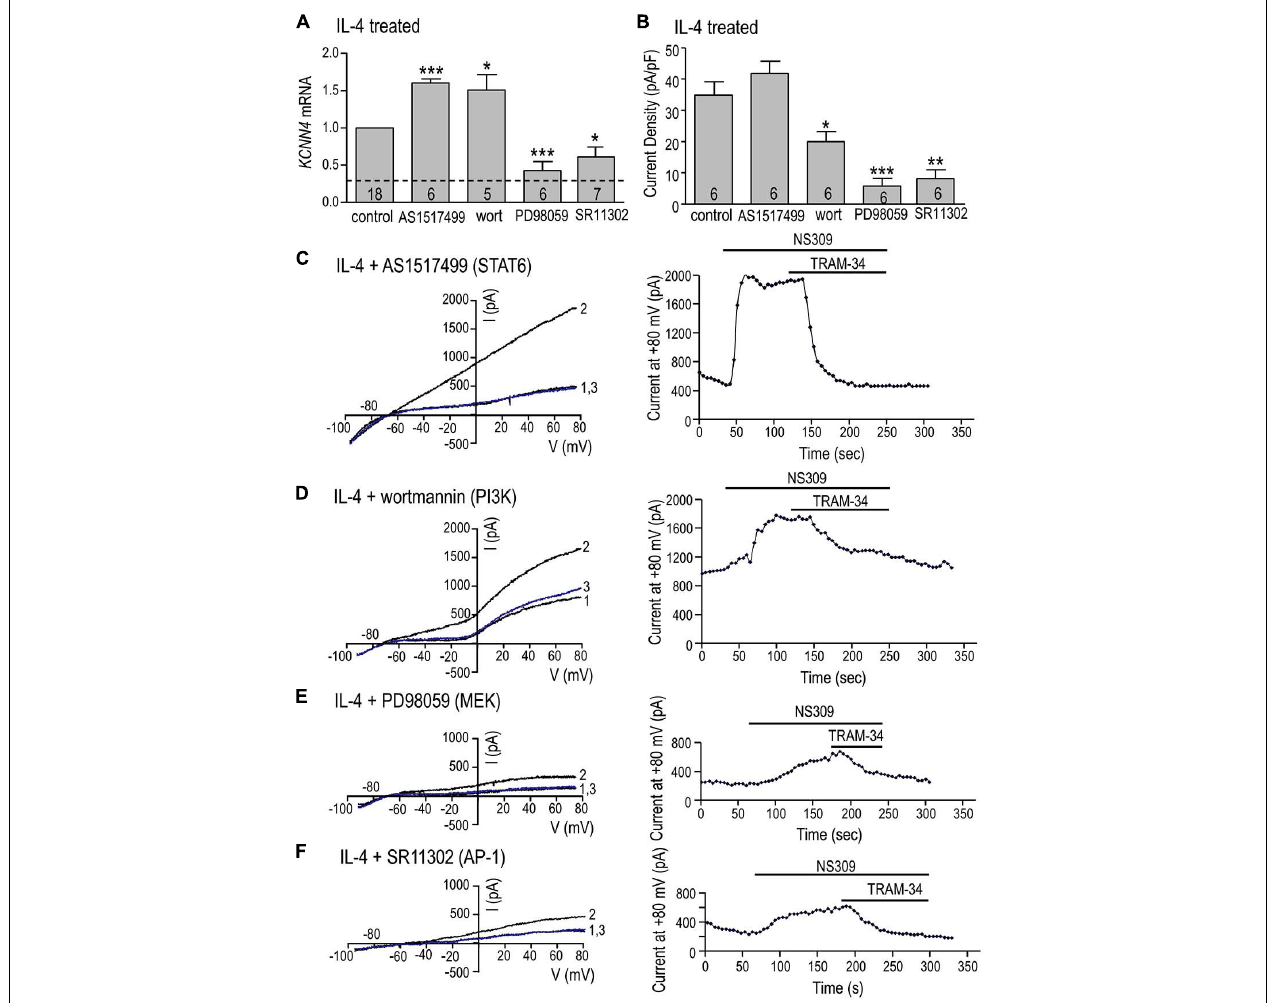
FIGURE 6 | Ras/MEK/ERK andAP-1 signaling are required for induction of KCNN4 mRNA and KCa3.1 current in IL-4 treated microglia. (A–F) Rat microglia were treated for 24 h with 20 ng/ml rat recombinant IL-4, without (control) or with an inhibitor of a signaling molecule: 200 nM AS1517499 (for STAT6), 100 nM wortmannin (for PI3K), 20 μ M PD098059 (for MEK1/2), or 1 μ M SR11302 (for AP-1). (A) IL-4-mediated induction of KCNN4 mRNA was examined using quantitative real-time qRT-PCR. Control KCNN4 mRNA levels in unstimulated microglia (no IL-4) are indicated by the dashed line. KCNN4 levels were normalized to IL-4-treated cells (set to 1.0) and compared with and without each inhibitor. (B) Summary ofTRAM-34-sensitive KCa3.1 current densities (pA/pF) that were evoked by NS309 and measured at + 80 mV in